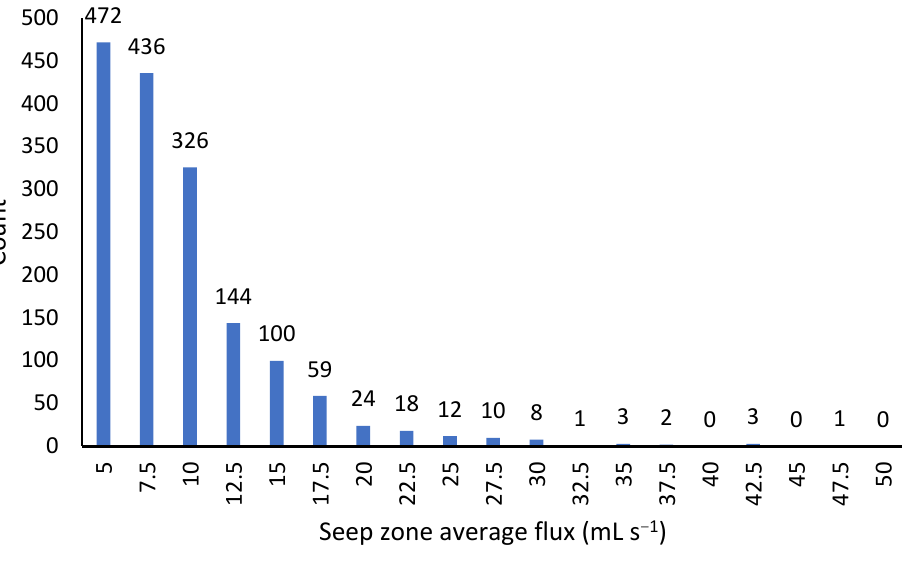
Figure 10. Comparison of seep zone depth to seep zone average flux. Inset enlarged to show lack of relationship between depth and average flux of seep zones.